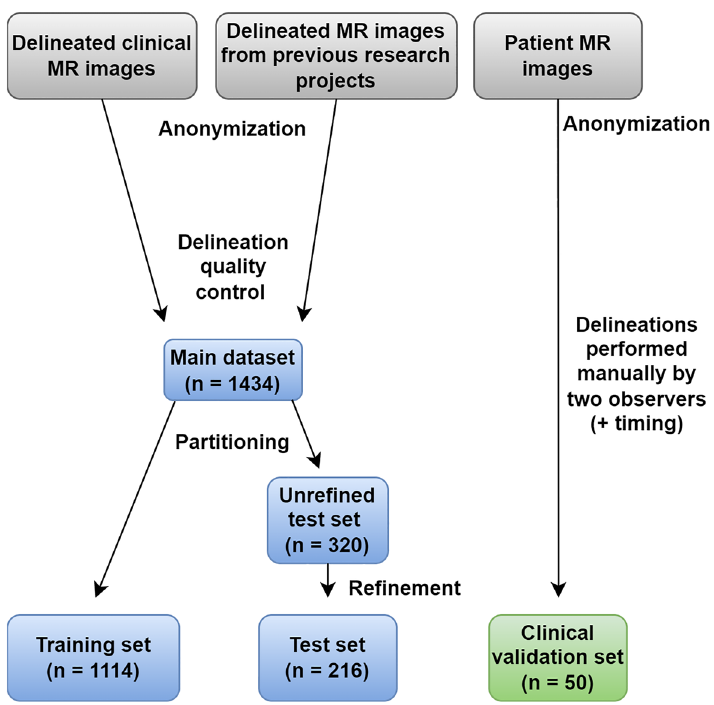
Figure 1. The data inclusion and data curation process. The refinement refers to the process of removing subjects with inadequate delineations in some